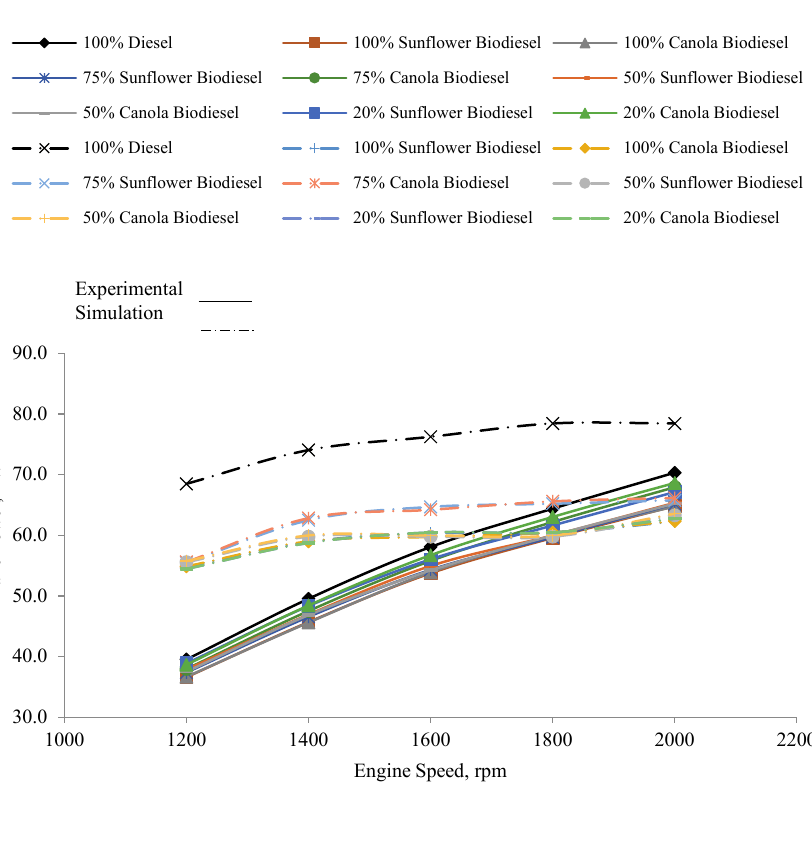
Fig. 14. Comparison of experimental and simulated brake power against